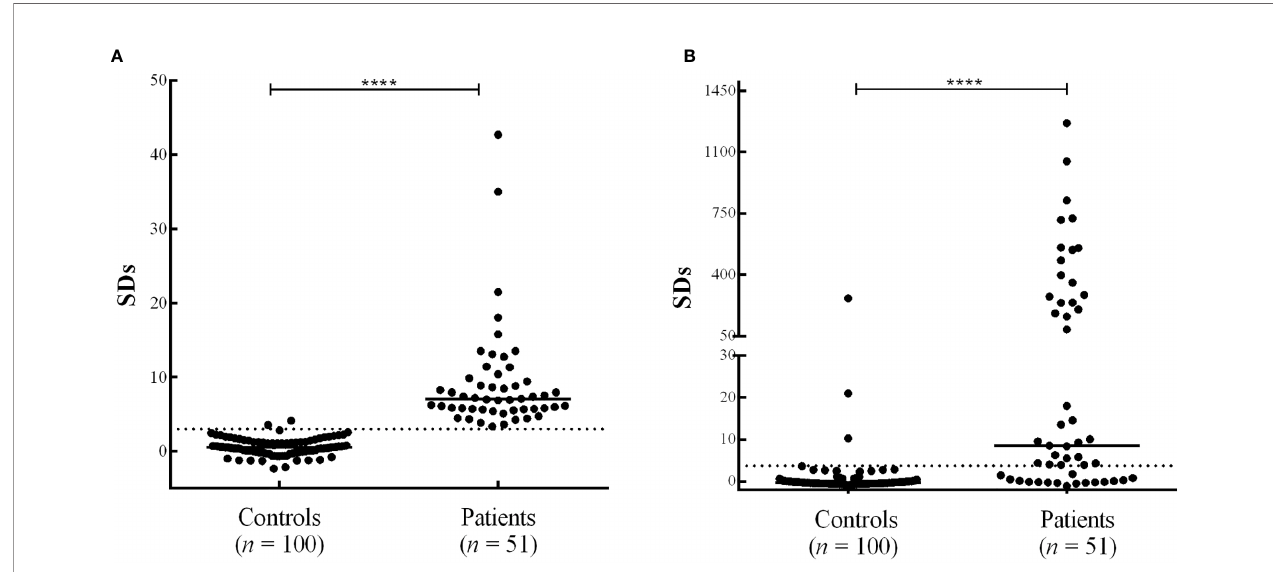
FIGURE 5 | PAA results obtained by RBA (A) and FloCMIA (B) from 100 normal human sera (controls) and 51 type 1 diabetic patients ’ sera. Results are expressed as SDs. The cut-off value (SDs >3.0) is indicated by a dotted line and medians for each population are indicated as a full line (****p < 0.0001).